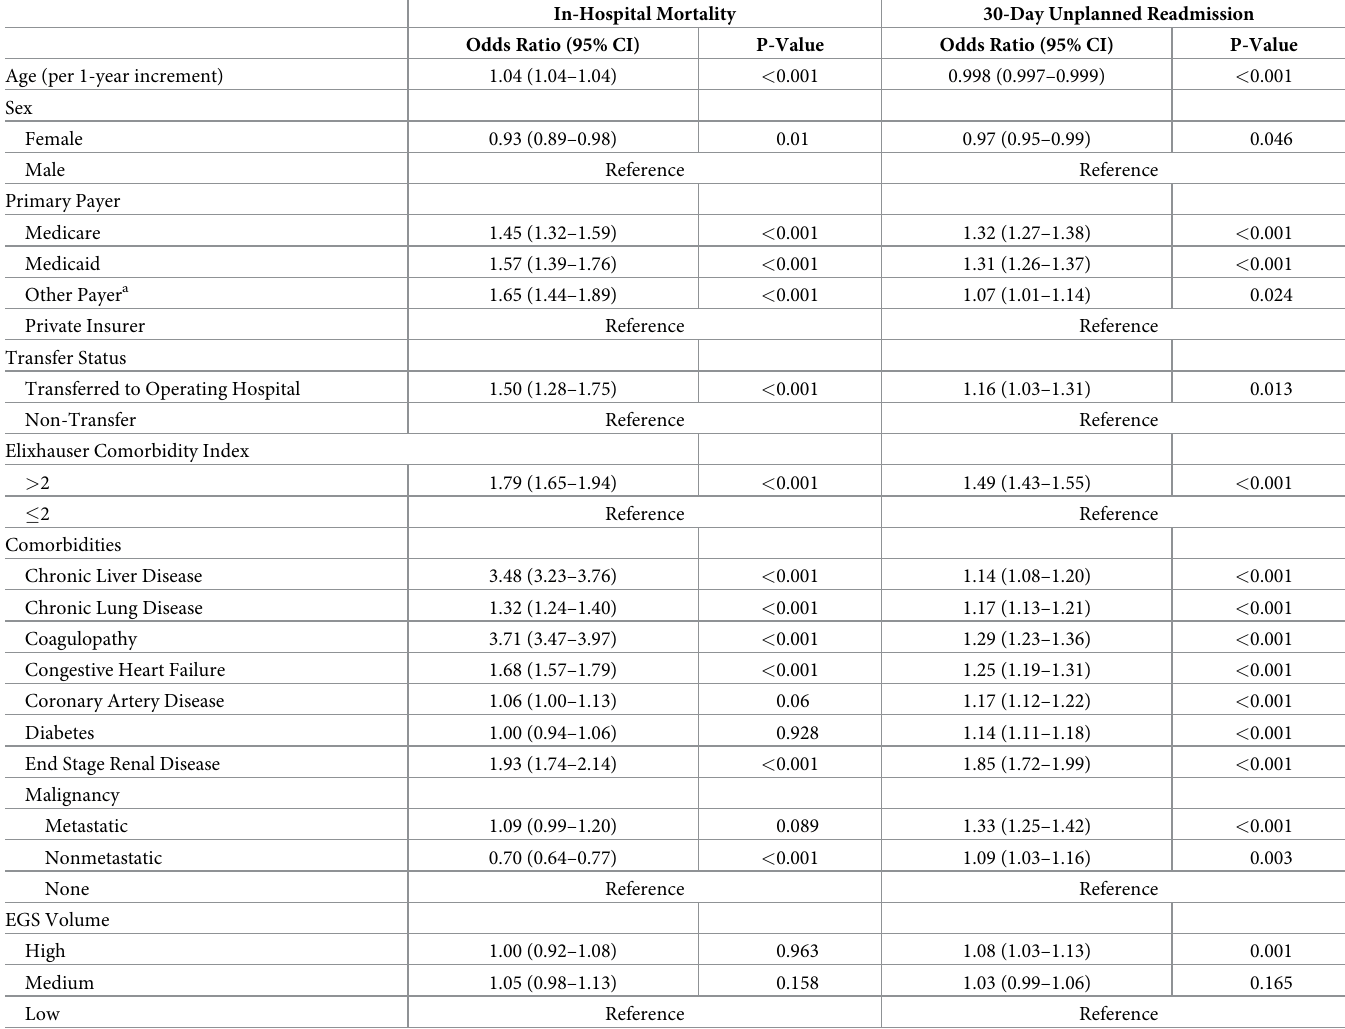
Table 3. Multivariable models for mortality at index admission and 30-day unplanned